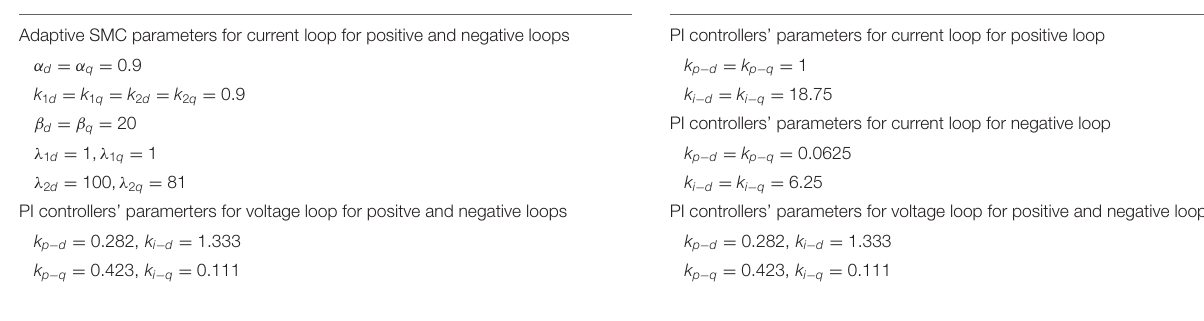
TABLE 3 | Parameters of PI